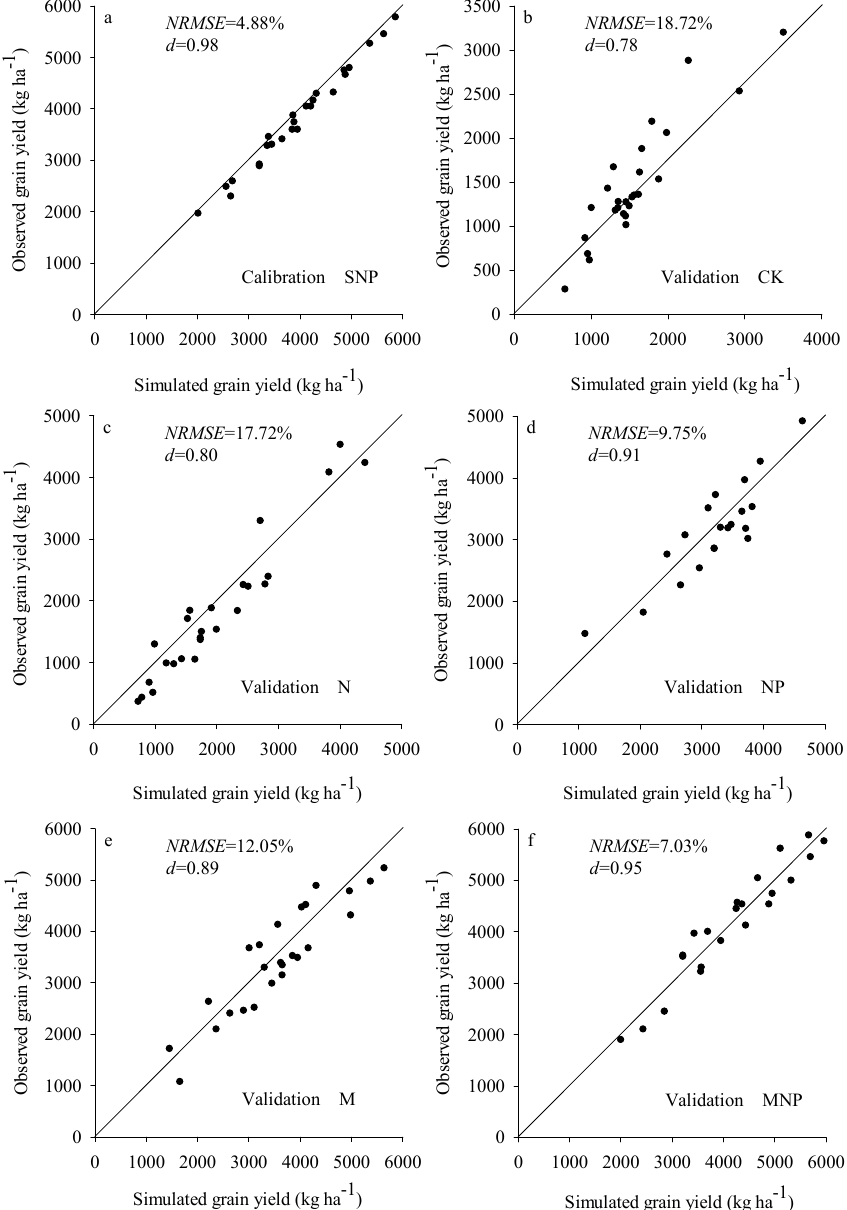
Figure 1. Relationship between measured and simulated yields of winter wheat under di ff erent fertilizations, 1981–2016. The solid line is